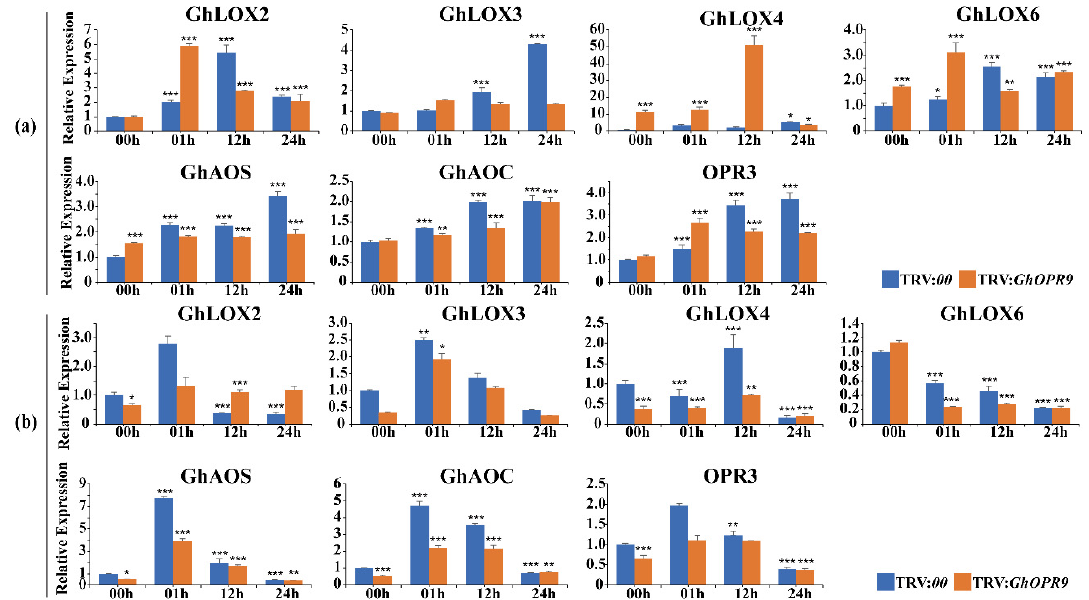
Figure 7. Real-time quantitative PCR analysis of the expression of JAs biosynthesis pathway genes at 00, 01, 12 and 24 h after Vd080 inoculation in the TRV: 00 and TRV: GhOPR9 plants. ( a ) The expression levels of JAs biosynthesis pathway genes under Vd080 inoculation in leaf. ( b ) The expression levels of JAs biosynthesis pathway genes under Vd080 inoculation in root. Values represent means ± standard deviation of three replicates. The TRV: 00 plants 00 h were used as the control. Asterisks reveal the gene significantly higher or lower in other time points than in 00 h by t -test (* p < 0.05, ** p < 0.01, *** p < 0.001).